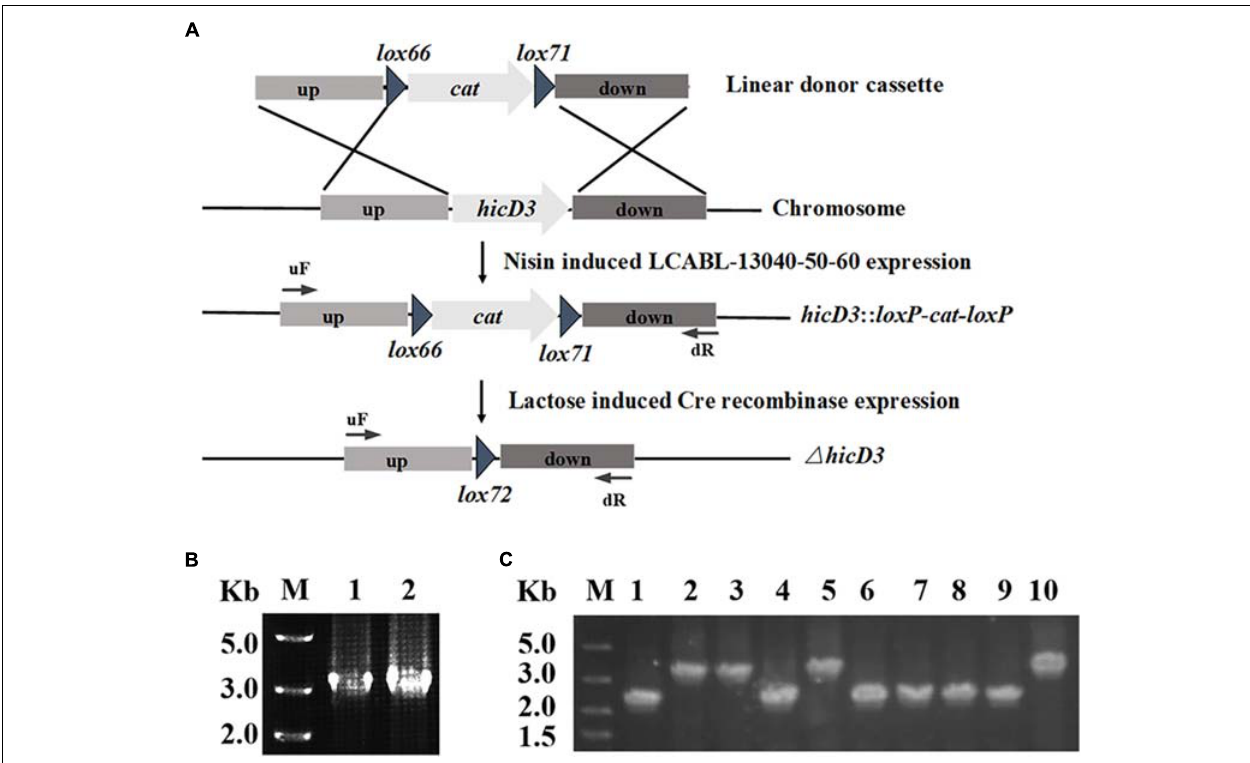
FIGURE 2 | Scheme for one gene deletion using the single-plasmid system in L. casei BL23. (A) Diagram showing in-frame hicD3 deletion and cat marker excision. Nisin induced LCABL_13040-50-60 mediated allelic replacement resulted in disruption of the hicD3 gene and insertion of the cat marker, while lactose induced Cre subsequently excised the marker. (B) Two single colonies were randomly picked and verified by PCR with the forward primer of the up homology (uF) and the reverse primer of the down homology (dR). The PCR fragment of the strain in which the cat gene has replaced the hicD3 gene was about 3.0 kb. (C) Ten colonies were randomly selected to tested by PCR with the forward primer of the up homology (uF) and the reverse primer of the down homology (dR) after Cre recombinase induction and incubation. The expected PCR fragment from the excision of the cat fragment was about 2.0 kb while the wild-type PCR fragment was about 3.0 kb.